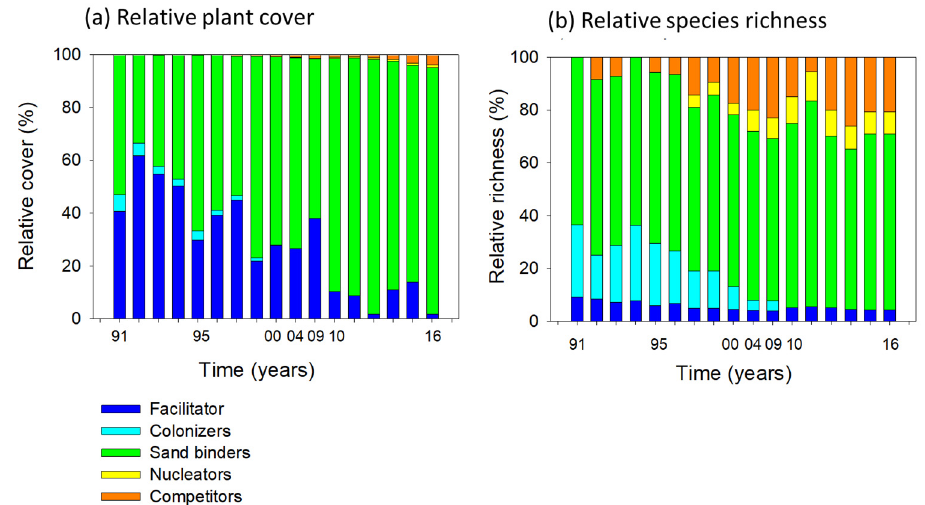
Figure 3. Temporal changes of ( a ) relative plant cover and ( b ) relative species richness during a 25-year successional sequence on mobile coastal dunes in Veracruz, located in the central region of the Gulf of Mexico. Successional groups and species included in each are described in Table 1.